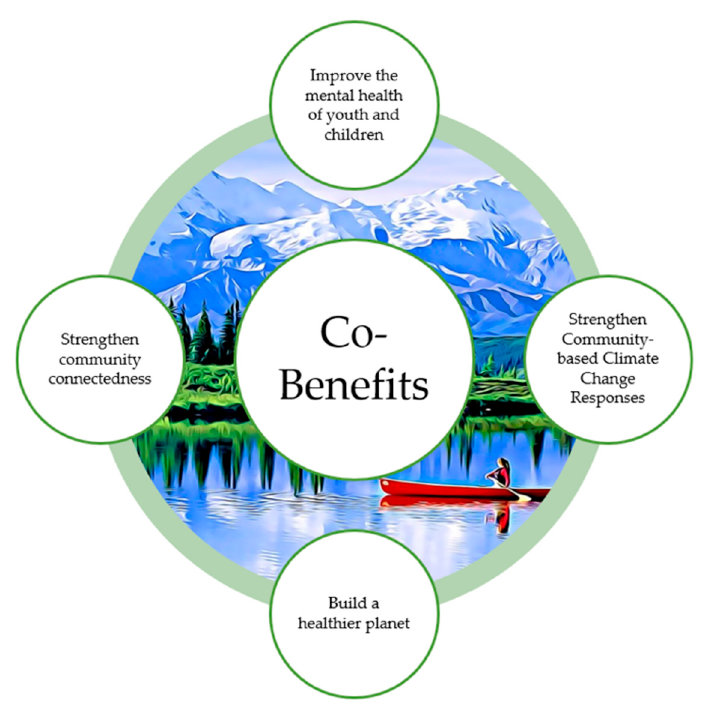
Figure 4. Co-benefits of working at the climate change, mental health, children/youth intersection.